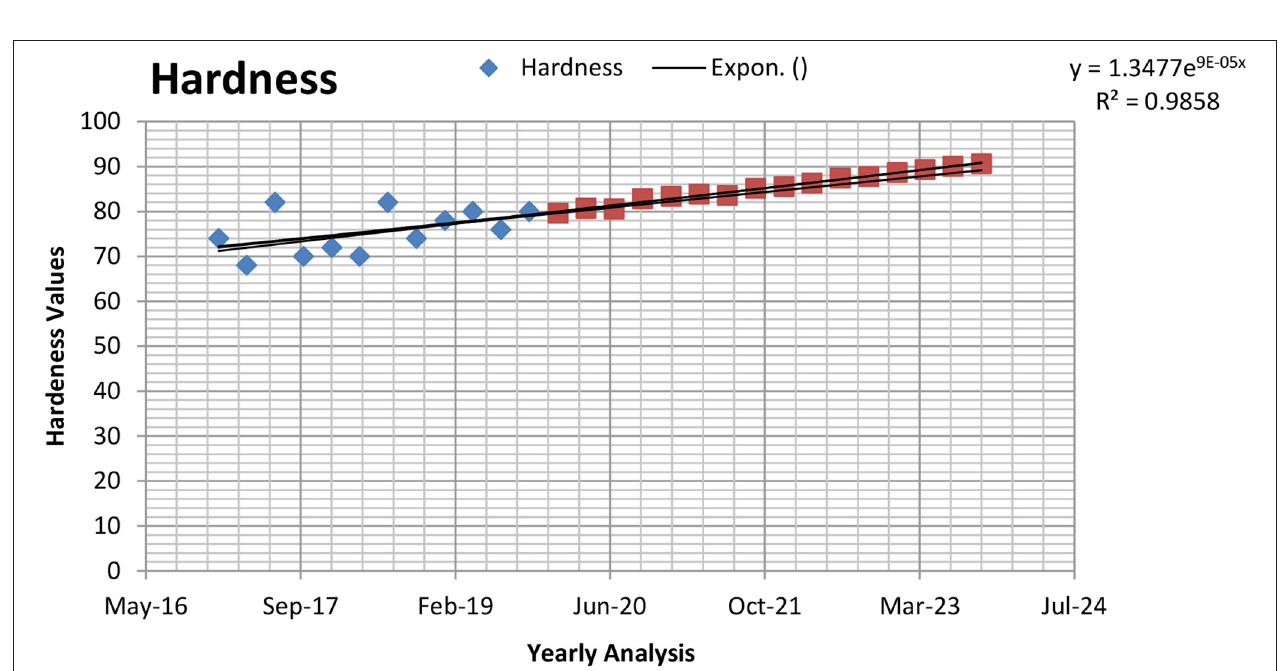
FIGURE 11 | Trend forecasting of hardness at Dehradun for the years from 2020 to 2024.